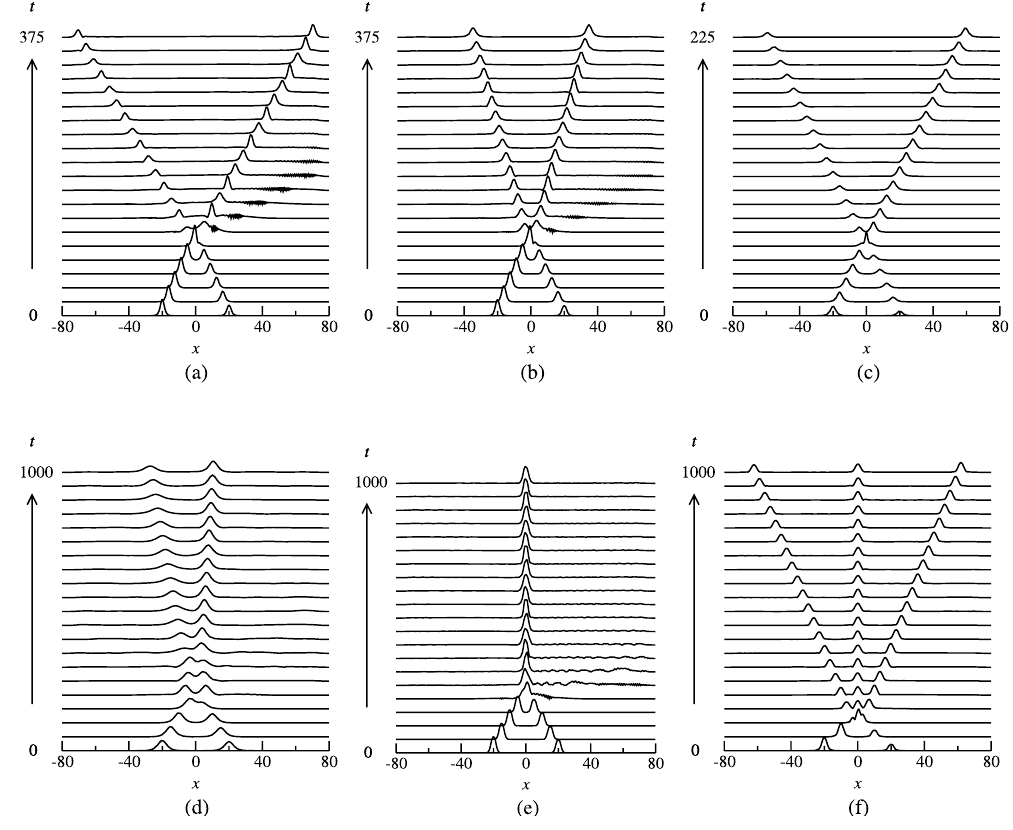
Figure 7. Examples of in-phase soliton collisions for κ = 10. ( a ) Symmetric separation with an increase in soliton velocity for δ = 0.2, Ω = − 9.93, m = 0.2 and c = 0.2; ( b ) symmetric separation with a decrease in soliton velocity for δ = 0.2, Ω = − 9.93, m = 0.3 and c = 0.2; ( c ) symmetric separation with unchanged velocity for δ = 0.35, Ω = 10.31, m = 0.05 and c = 0.2; ( d ) Asymmetric separation for δ = 0.1, Ω = 10.31, m = 0.4 and c = 1; ( e ) merger into a zero velocity soliton for δ = 0.1, Ω = − 10.10, m = 0.5 and c = 0.2; and ( f ) generation of three solitons with two moving ones and a quiescent soliton for δ = 0.2, Ω = 10.16, m = 0.5 and c = 0. Only | u | is shown.